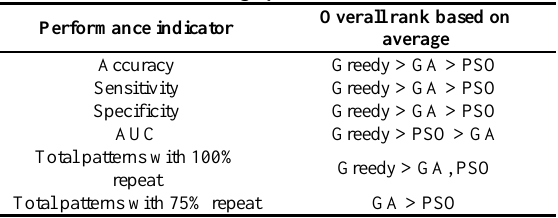
Table 6. Overall rank of mutation technique rank based on average